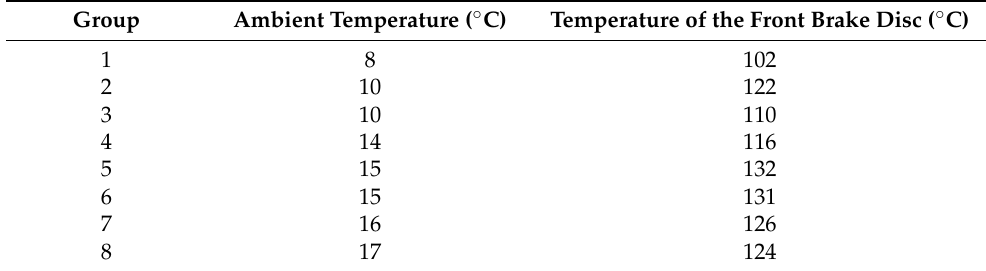
Table 6. Static disc temperature under normal driving conditions (adventurous driver).